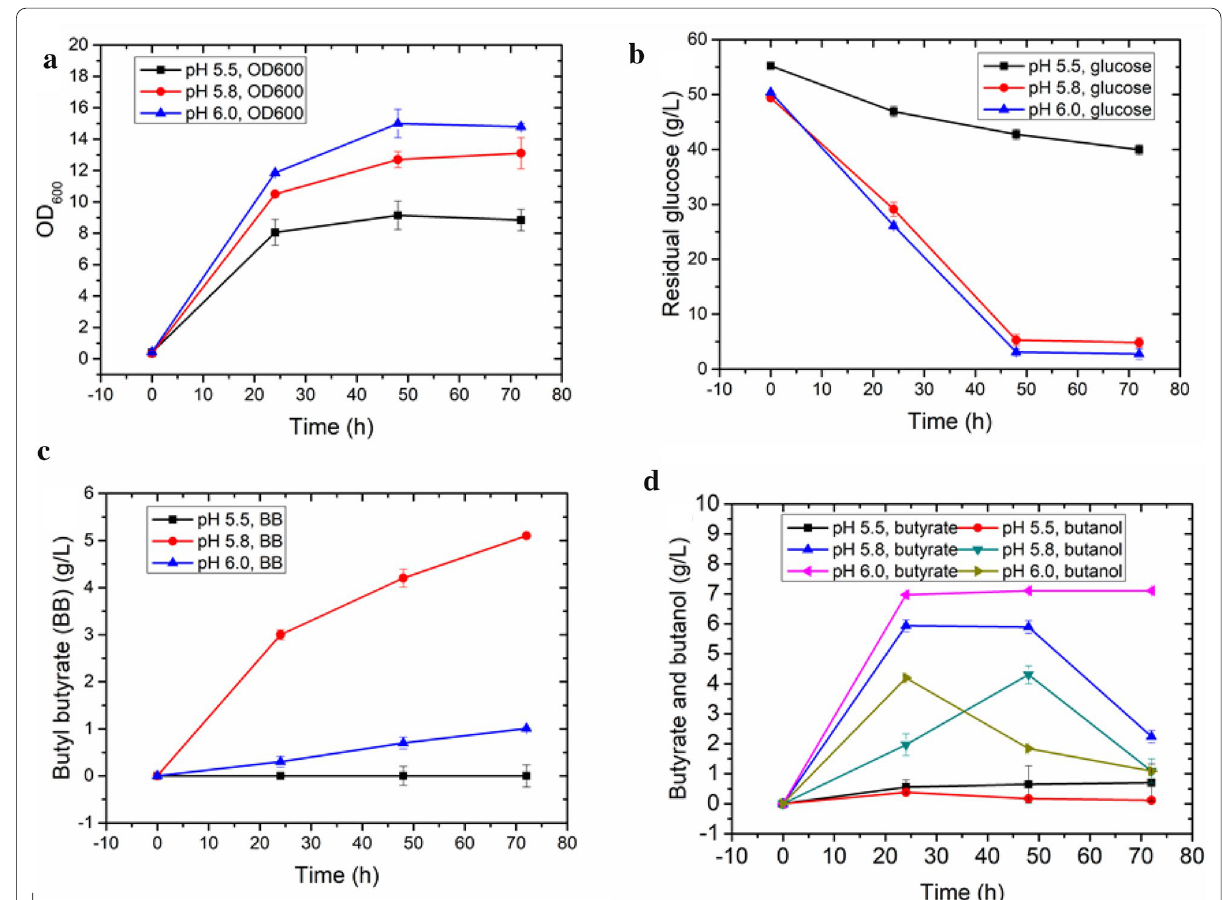
Fig. 4 Bioreactor batch fermentation profiles of the two strains for butyl butyrate production at different pH values. The strains were seeded at an inoculation ratio of 1:4 (butyrate-producing strain (EB243Δ adhE2:: yciAh): butanol-producing strain (EB243) in modified M9Y medium supplemented with 50 g/L glucose. The system was composed of the fermentation broth and hexadecane as extractant at a volume ratio of 1:1. a Optical density at 600 nm (OD 600 ), b glucose consumption, c butyl butyrate produced during the fermentation, and d butyrate and butanol. All parameters were assessed at pH 5.5, 5.8, and 6.0. Butyrate, OD 600 , butanol, butyl butyrate, and glucose were measured every 24 h. Error bars indicate the standard deviations from three biological